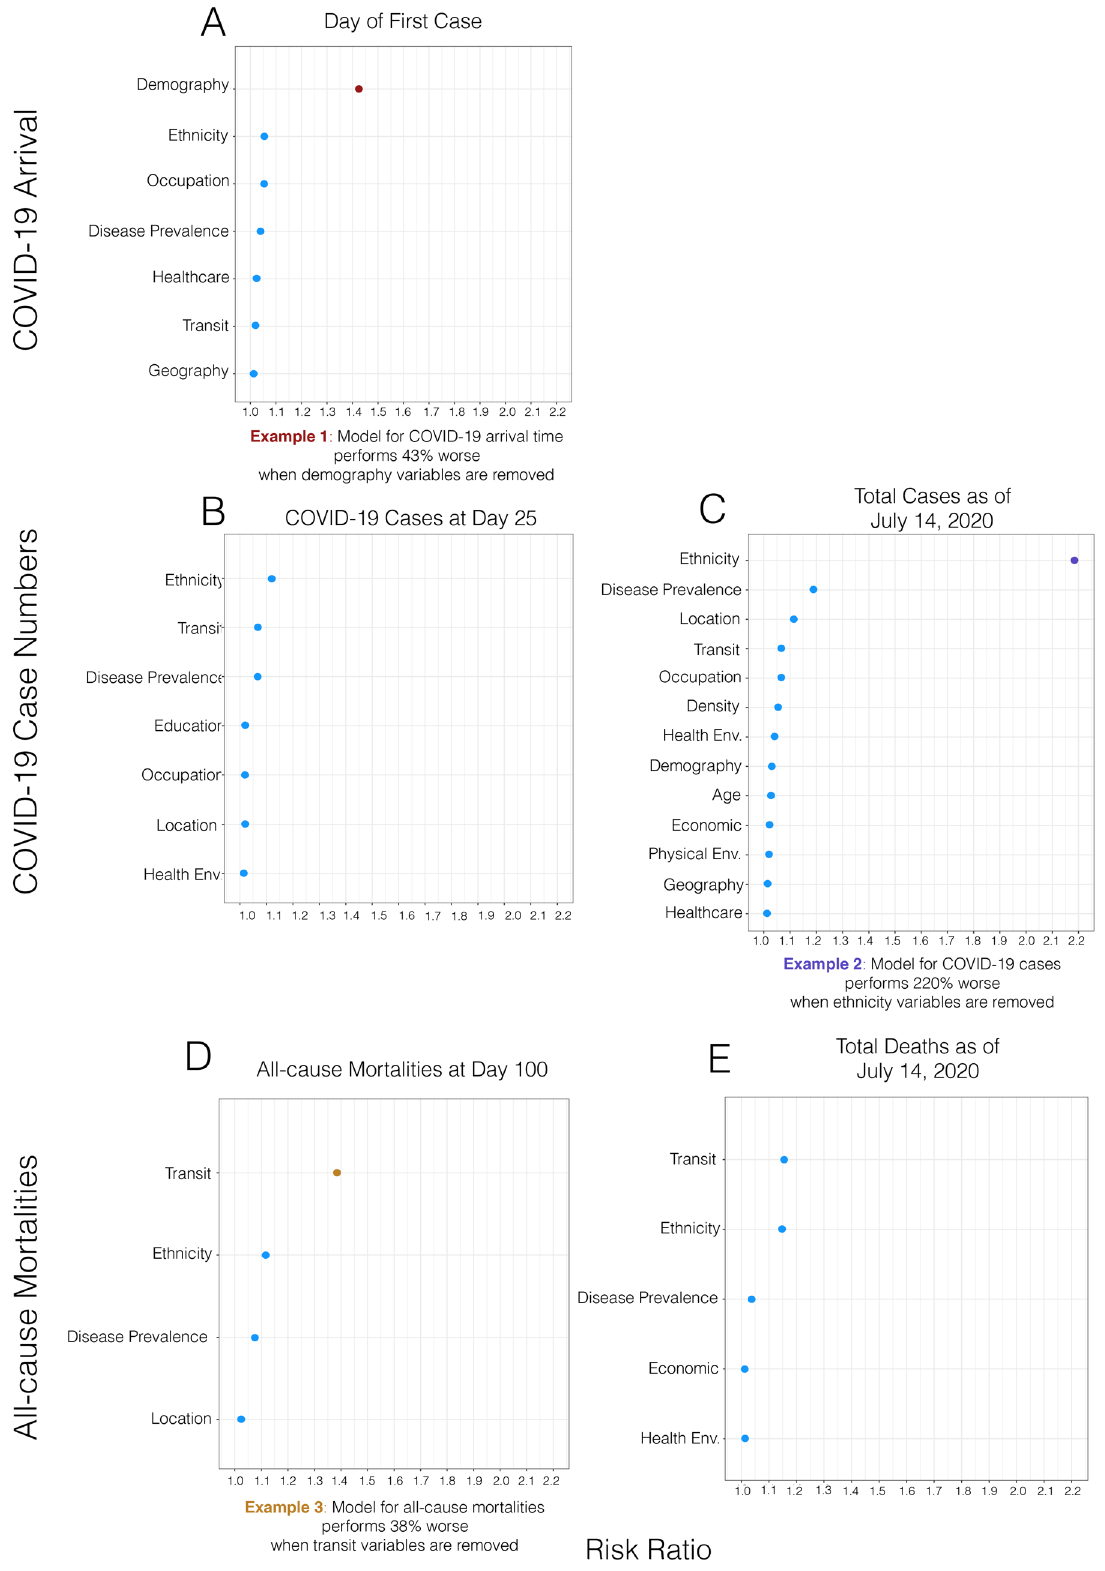
Figure 2. Variable importance as indicated by the relative increase of mean-squared error when the block of variables is